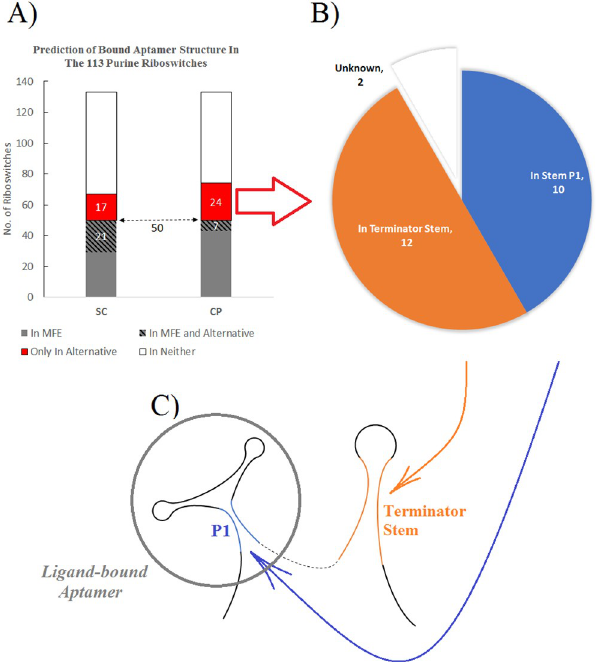
Fig 5. Alternative structure prediction in the purine riboswitch dataset. We examined the predicted structures S � , and ^ S � for Stem P1, a substructure of the bound aptamer. A) The number of predicted structures containing Stem S � 2 2 P1. The left bar corresponds to SC (which predicts S � location of the stem seed L � for the 24 sequences where CP predicted the bound aptamer in S � schematic structure of a typical ligand-bound purine